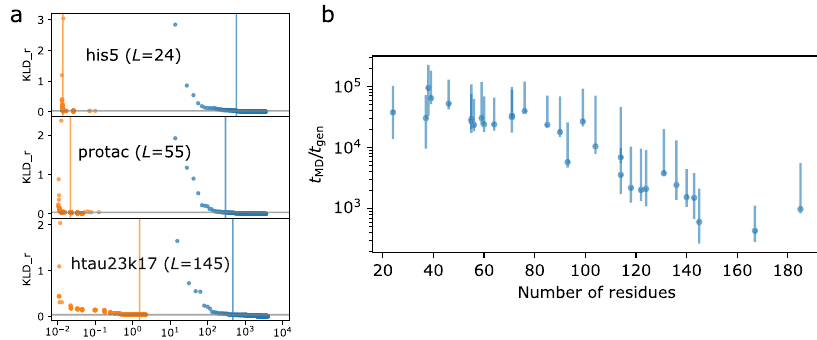
Fig. 7 | Evaluation of idpGAN sampling ef fi ciency compared to MD. a KLD_r between the idpGAN and reference MD ensembles (orange data points) and betweenshortMD and referenceMD ensembles (bluedatapoints) asa functionof GPUtime. Orange verticallinesindicate the GPU time( t gen ) atwhich the generator reachesaplateauKLD r top value,whichismarkedbyagrayhorizontalline.Theblue vertical lines indicate the GPU time ( t MD ) needed by MD to surpass the KLD r top